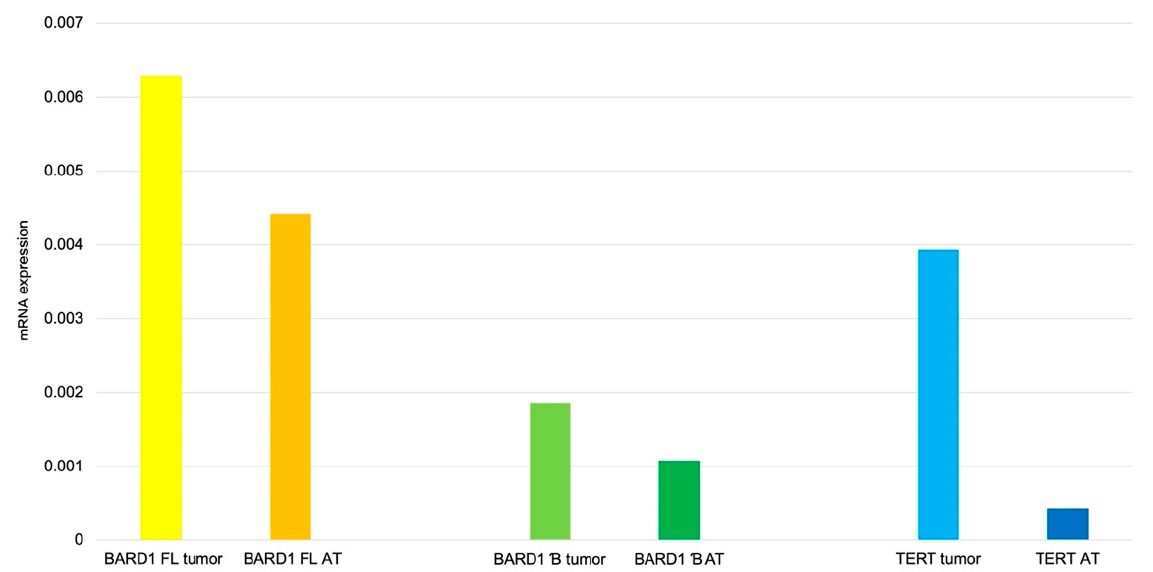
Figure 6. TERT and BARD1 isoforms expression levels of RMS samples. Histogram of mRNA expression for TERT, BARD1 FL , and BARD1 β isoform of RMS samples. Results are depicted as median. AT-adjacent tissue.